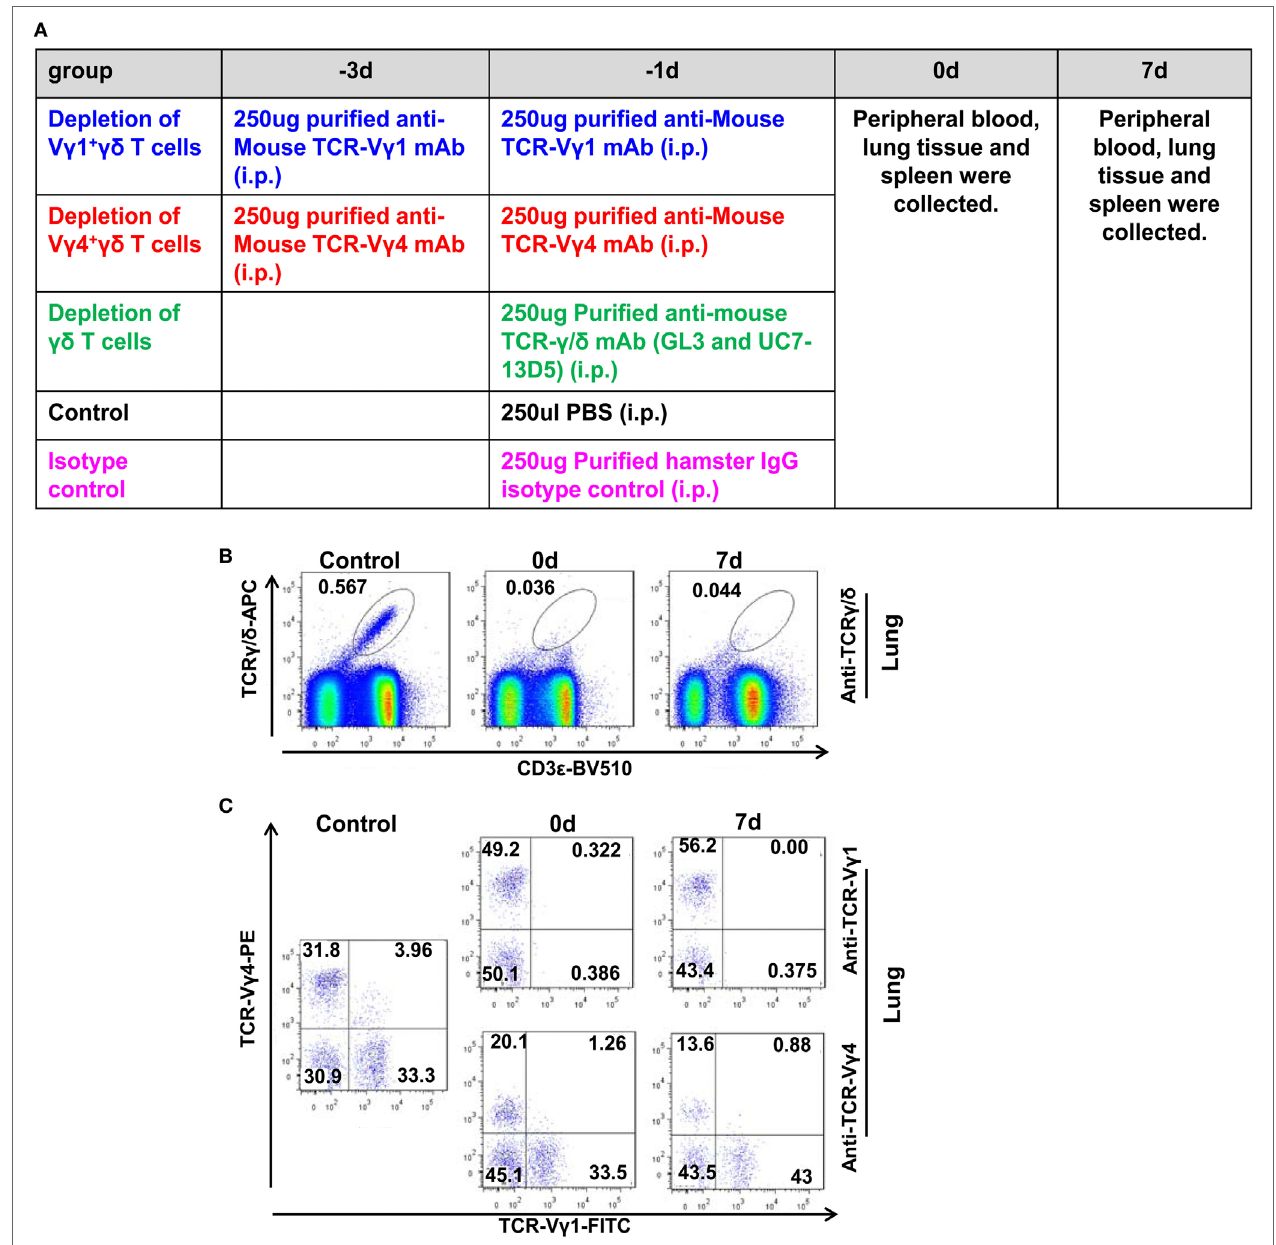
FigUre 7 | Depletion of γδ T cells and the V γ 1 + γδ T or V γ 4 + γδ T subsets. (a) Schematic diagram of the methods used to deplete the indicated cells, based on the detailed description in Section “Materials and Methods.” Depletion of lung γδ T cells [ (B) gated on lung lymphocytes] and the V γ 1 + γδ T or V γ 4 + γδ T subsets [ (c) gated on lung CD3 + γδ TCR + lymphocytes] was detected using flow cytometry at 0 and 7 dpi. The numbers represent the proportion of different subsets in the lungs after depletion. The results are representative of two independent analyses ( n = 3 for each group).